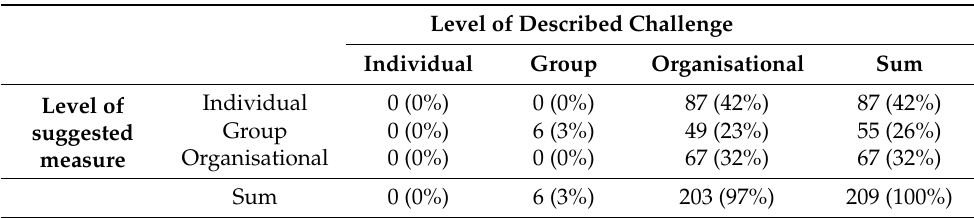
Table 4. Levels of the challenges described and measures suggested for the 209 submitted